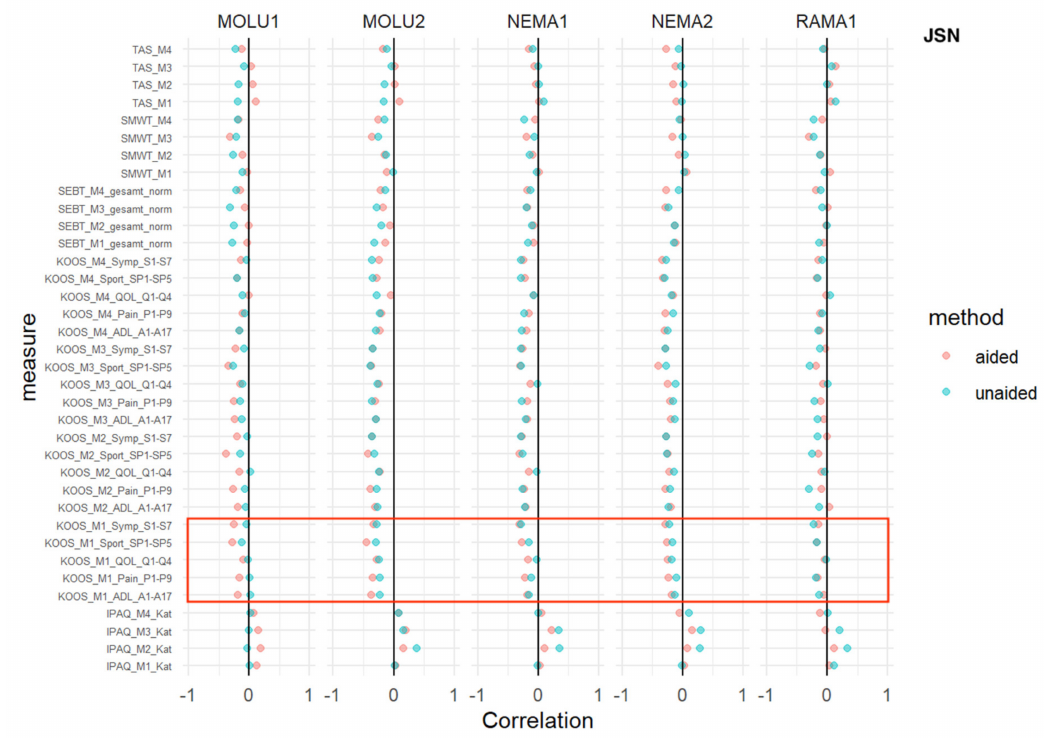
Figure 6. Joint-space narrowing (JSN) —correlation analysis for AI-aided (red dots) versus AI- unaided (green dots) readings with clinical scores. Red square marks all baseline KOOS scores (=“KOOS_M1_x_x”).